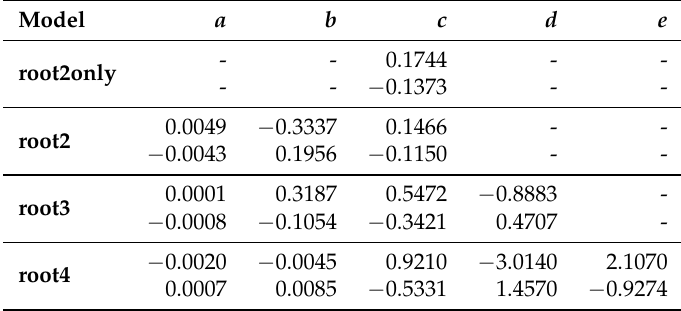
Table 1. Root function coefficients with all participants’ data (inclusive) for Equations (7) and (8).